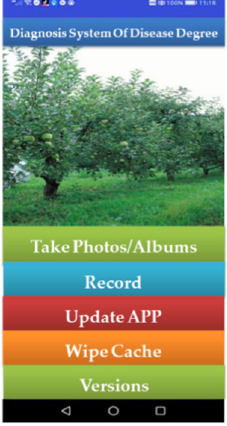
Figure 11 . The main interface of the app.